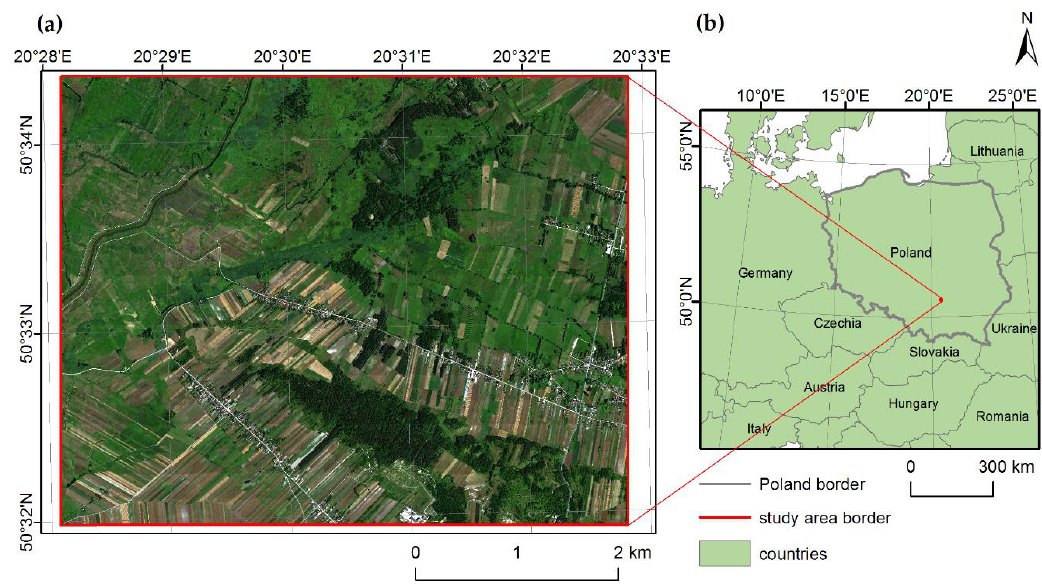
Figure 1. Study area location. Ostoja Nidziańska ( a ), basemap: HySpex image in natural colour Red, Green, Blue (RGB) composition, acquired in September 2017; Central Europe ( b ), basemap: © EuroGeographics for the administrative boundaries.